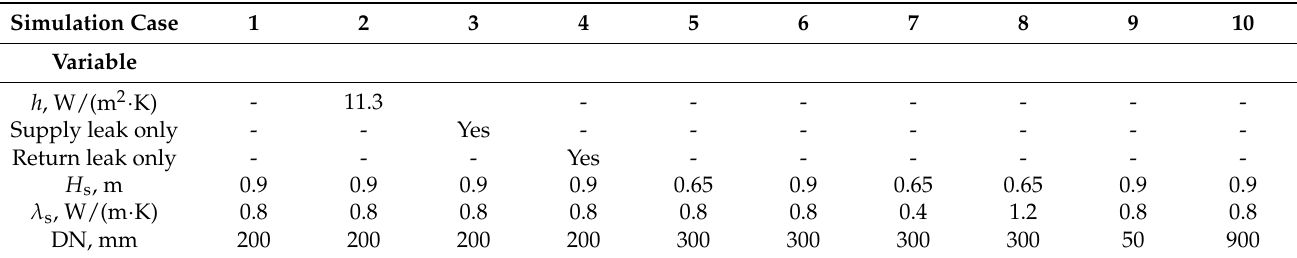
Figure 2. ( a ) Computed soil temperature fields above the channel for Simulation Case 1 and ( b ) soil temperature gradient ratio for different equivalent thermal conductivities of the insulation. Table 1. Operating conditions for the simulation